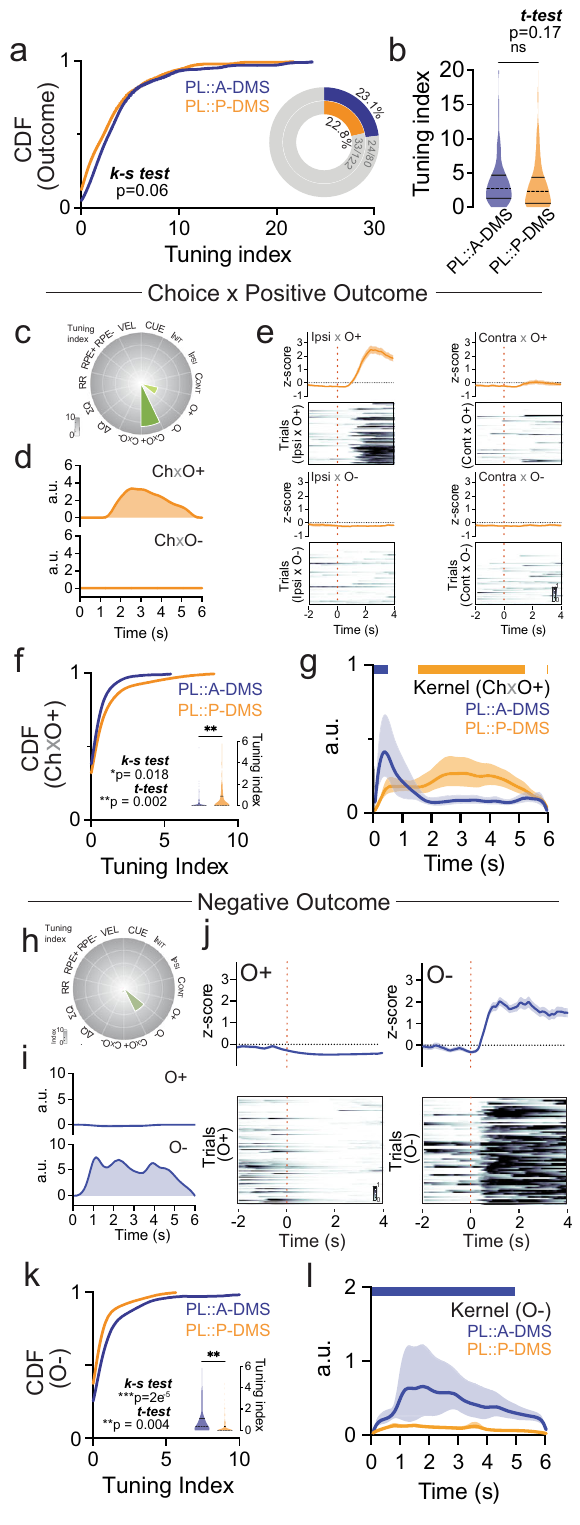
Fig. 6 | Divergent encoding ofoutcome by PL::DMS pathways. a Comparison of cumulative distribution of outcome group tuning index ( p =0.06, Two-sided Kolmogorov – Smirnov test) and the proportion of highly tuned neurons to out- come group predictor ( insets , >5% tuning index). b Comparison of average tuning index (Shaded area, Kernel probability density; solid line, quartile=1.309,4.695/ 0.5896,4.394; dotted line, median=2.695/2.318) between PL::A- or P-DMS for out- come predictors ( p =0.17, PL::A-DMS, n =104 cells; PL::P-DMS, n =154 cells, Two- sidedunpairedt-test). c TuningplotshowingrepresentativeChxO+tunedneuron fromPL::P-DMS. d EncodingmodelinferredkernelscorrespondingtoChxO+( top ) and Ch x O- ( bottom ). e Four interactions of PETH ( top ) and trial-by-trial neuronal activity ( bottom ) aligned by outcome. Solid line, mean; shaded area, ±SEM. f Comparison of cumulative distribution ( p =0.02, Two-sided Kolmogorov-Smir- novtest)andaveragetuningindex(insets;Shadedarea,Kernelprobabilitydensity; solid line, quartile=0, 0.2009/0, 0.8864; dotted line, median=0, 0) of Ch x O+ tuned neurons in both PL-A/P-DMS pathways ( p =0.002, PL::A-DMS, n =104 cells; PL::P-DMS, n =154 cells, Two-sided unpaired t-test). * p <0.05, ** p <0.01. g Comparison of model inferred Ch x O+ kernels on average for both PL-DMS pathways. Solid line, RMS; shaded area, ±95% con fi dence interval. Colored bar on top indicates timepoints for which RMS kernels are signi fi cantly different between pathways (bootstrap test). h Tuning plot showing representative O- tuned neuron from PL::A-DMS. i Encoding model inferred kernels corresponding to O+ ( top ) and O − ( bottom ). j PETH ( top ) and trial-by-trial neuronal activity ( bottom ) aligned by outcome. Solid line, mean; shaded area, ±SEM. k Comparison of cumulative dis- tribution ( p =2e − 5, Two-sided Kolmogorov – Smirnov test) and average tuning index (insets; Shaded area,Kernel probability density; solid line, quartile=0,1.107/ 0,0.3613; dotted line, median=0.3689/0) of O- tuned neurons in both PL-A/P-DMS pathways ( p =0.004, PL::A-DMS, n =104 cells; PL::P-DMS, n =154 cells, Two-sided unpaired t-test). ** p <0.01, *** p <0.001. l Comparison of model inferred O- kernels on average for both PL-DMS pathways. Solid line, RMS; shaded area, ±95% con- fi denceinterval.ColoredbarontopindicatestimepointsforwhichRMSkernelsare signi fi cantly different between pathways (bootstrap